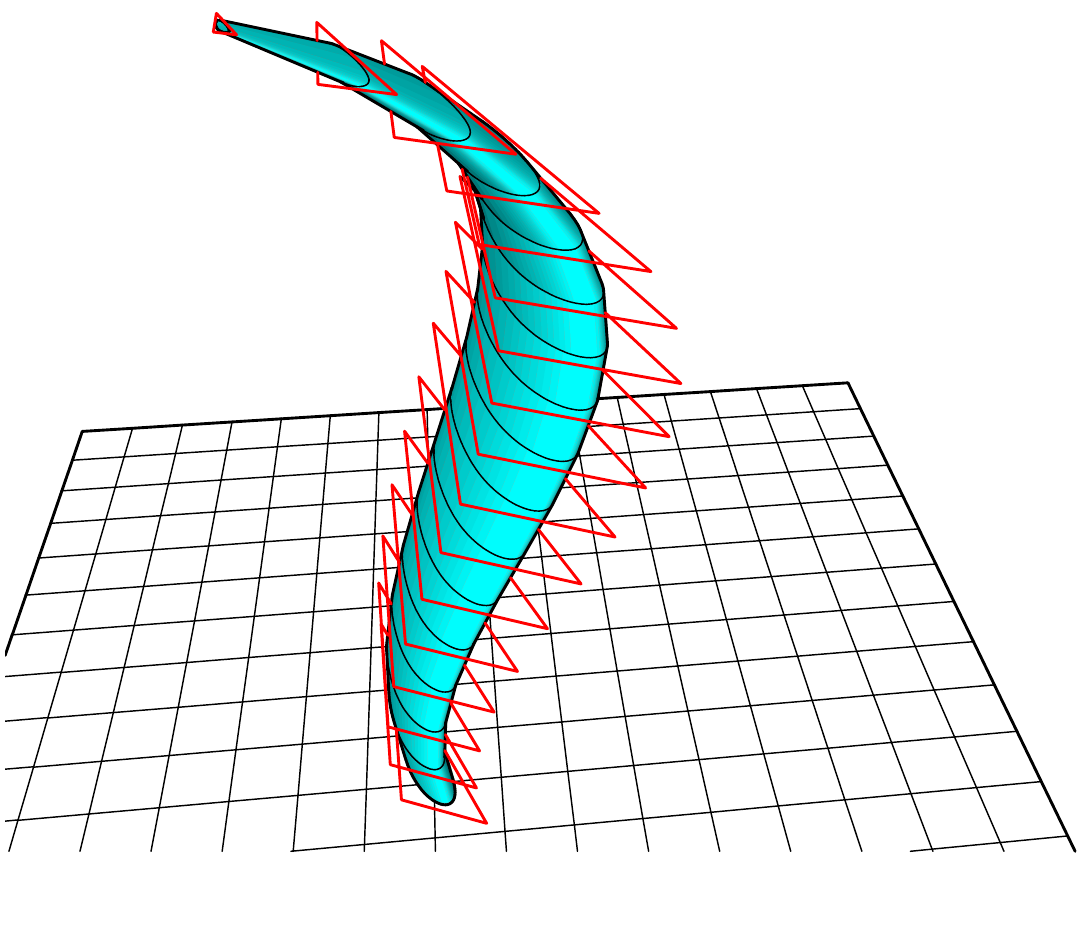
Figure 19. Developable surfaces generated by ruling between the secondary homothetic splines already created, see Figure 18.